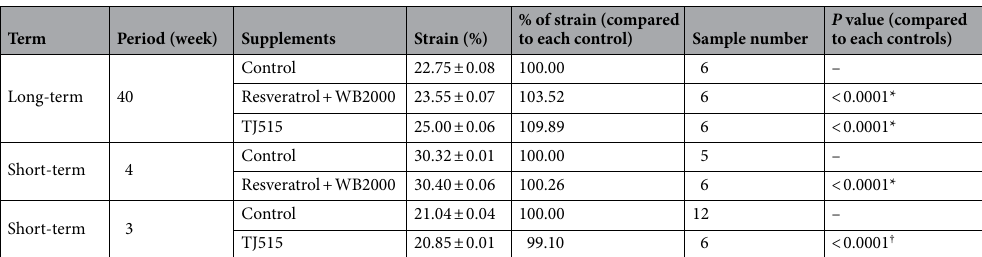
Table 2. The effects of treatment with resveratrol and WB2000 together or TJ515 alone on rat lens elasticity. As shown in Fig. 2, the percentages of strain for the three groups when lenses were pushed with 0.05 Newtons (N) of force are shown. Data are presented as mean ± SEM. The asterisk and dagger indicate statistically significant difference compared to each control (*, † P < 0.05, one-way analysis of variance followed by Tukey’s post-hoc test or Student’s